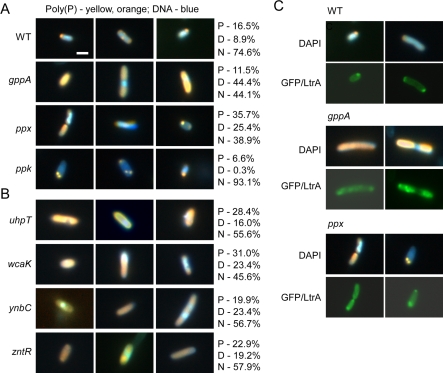
Fluorescence Microscopy of Poly(P) and GFP/LtrA Localization in Wild Type and DisruptantsWild-type HMS174(DE3) (WT) and disruptants containing pACD2X-GFP/LtrA were induced with 500 μM IPTG overnight at 30 °C, stained with DAPI, and examined by fluorescence microscopy. In cells stained with DAPI, poly(P) appears yellow or orange, and DNA appears blue. At least 200 randomly selected cells were analyzed in each case. Proportions of cells with normal morphology showing polar (P), diffuse (D), or no detectable fluorescence above background (N) are indicated to the right.(A) Poly(P) localization in WT, gppA, ppx, and ppk disruptants.(B) Poly(P) localization in uhpT, wcaK, ynbC, and zntR disruptants.(C) Selected examples of cells showing poly(P) and GFP/LtrA colocalization.Bar = 2 μm.